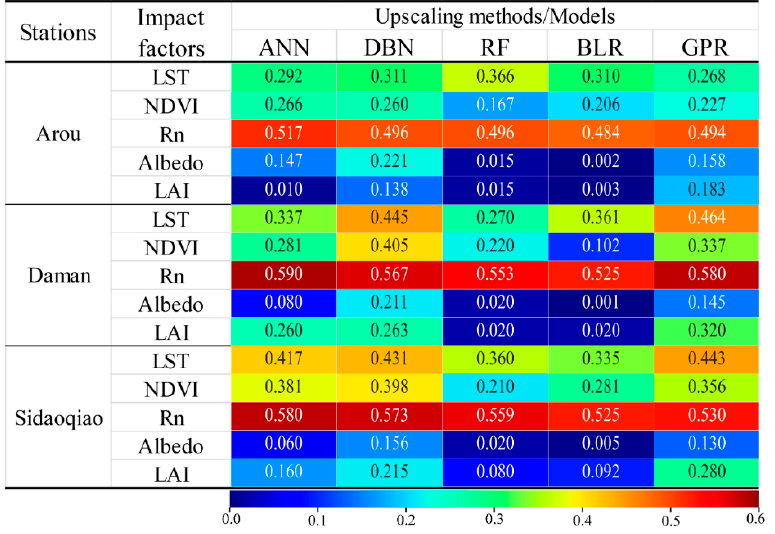
Figure 4. Sensitivity analysis at the Arou, Daman, and Sidaoqiao superstations in 2015. (The colors from green to red represent the index of the total effects from small to large).